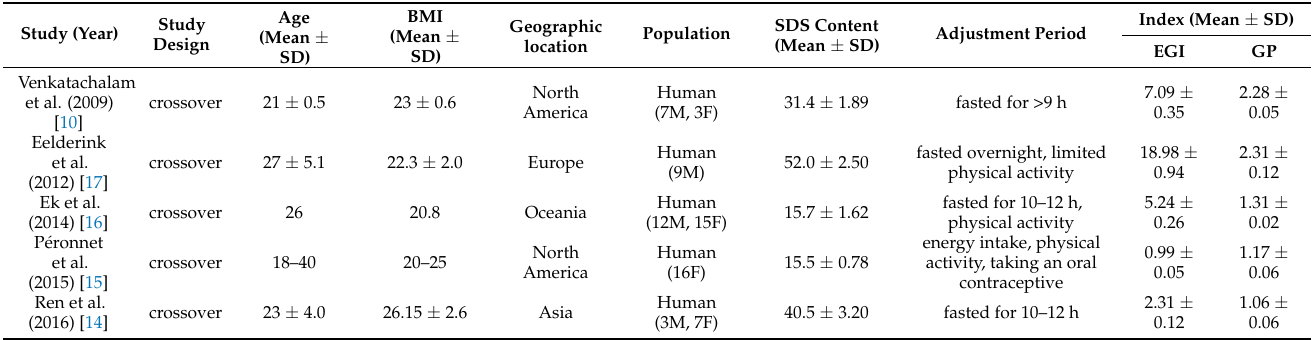
Table 1. Characteristics of the five studies included in the individual analysis.